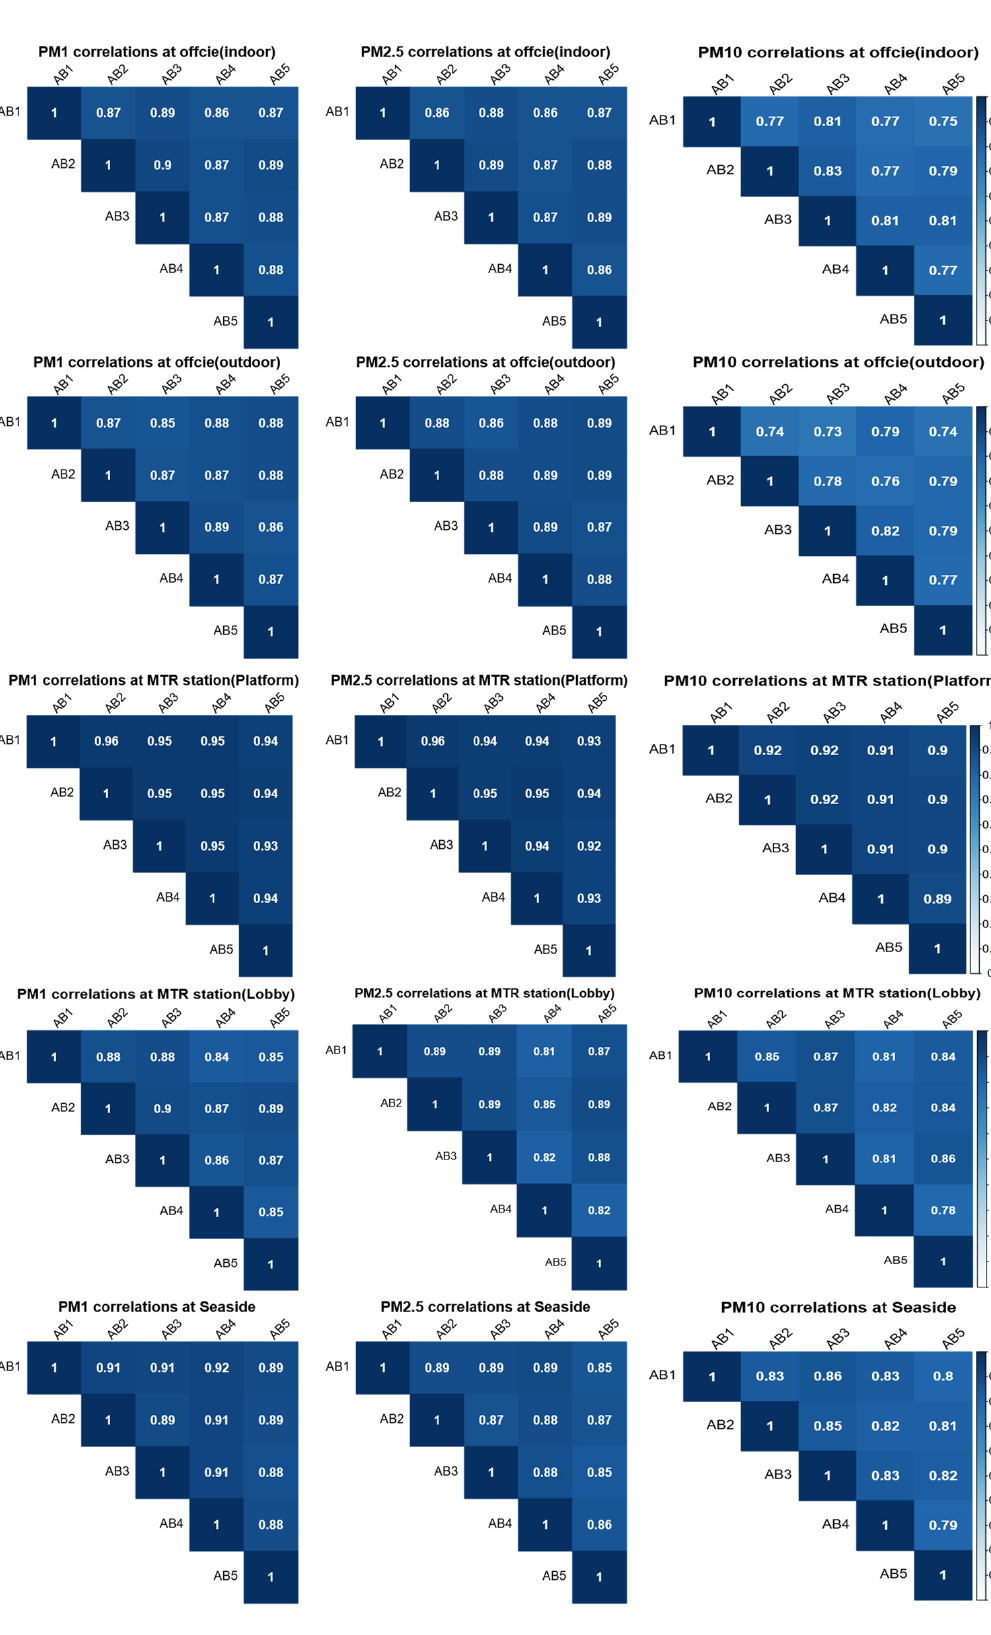
Figure 2. Correlation matrix for the 1 min PM 1 , PM 2.5 , and PM 10 average concentrations ( μ g/m 3 ) reported by the AirBeam2 sensors.